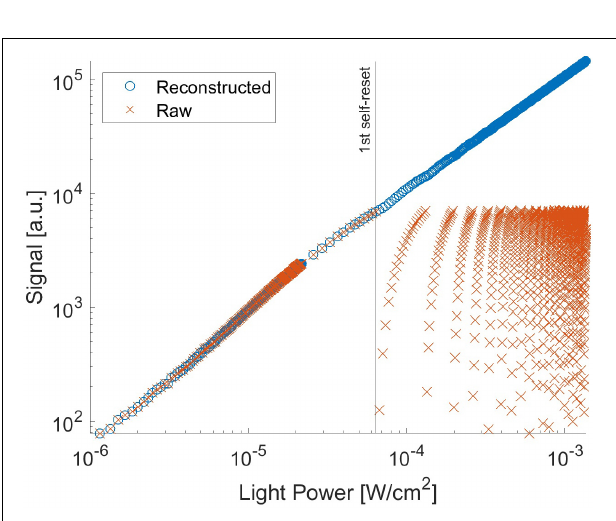
FIGURE 7 | Signal from the pixel with P+/N-well/P-sub photodiode as a function of the light intensity.